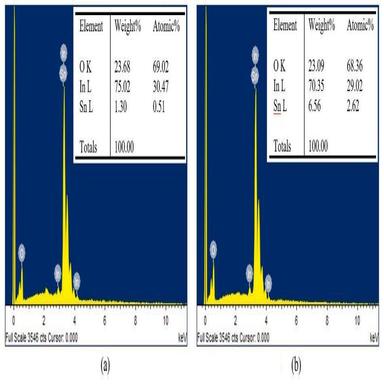
EDX results for one region and summary of compositions: (a) untreated and (b) annealed films.